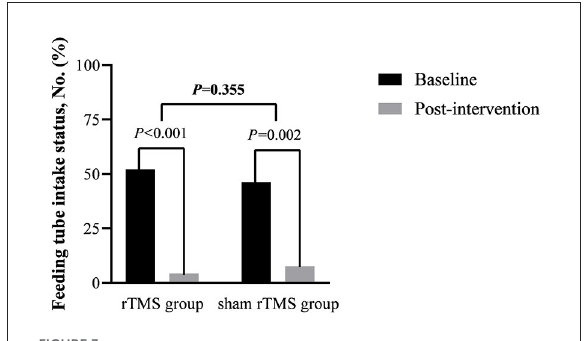
FIGURE3 Feeding tube intake status, No. (%).